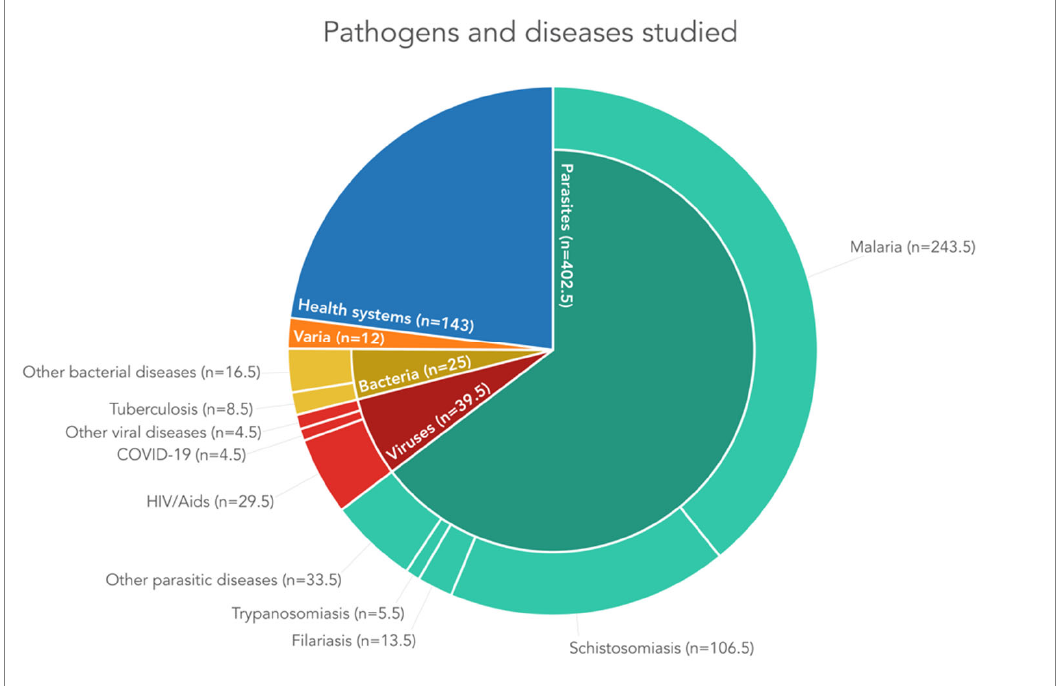
Figure 5. Diseases and pathogens studied, as revealed by content analysis of Marcel Tanner’s research output between 1978 and 2021. Note: the figure displays the types of pathogens in the inner pie chart and the accompanying diseases in the outer ring.